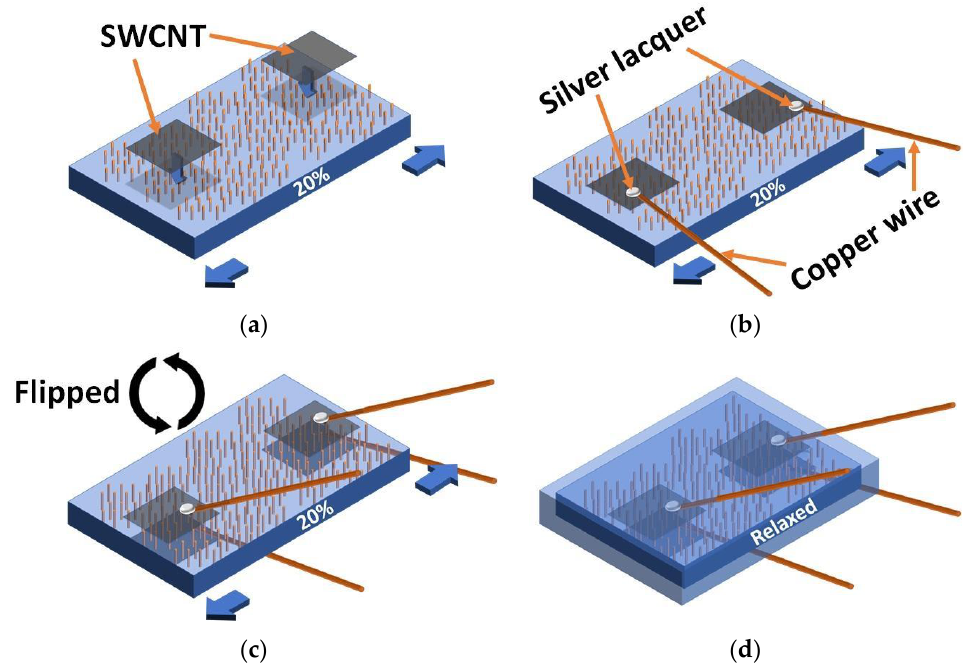
Figure 2. Workflow of electrical contacting to a PDMS/MW membrane: ( a ) application of SWCNT contact pads onto the upper side of 20% pre-stretched PDMS/MW membrane, ( b ) connection to the SWCNT contact pads with copper wires and silver lacquer, ( c ) application of electrical contact to the bottom side of PDMS/MW membrane, ( d ) relaxed LED device buried into PDMS.